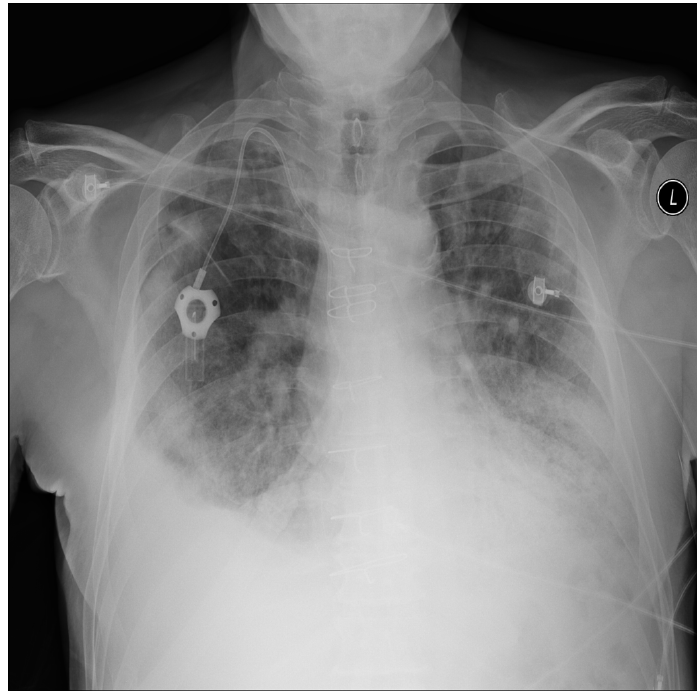
Figure 10. Pneumonia sample: X-ray Image dataset.